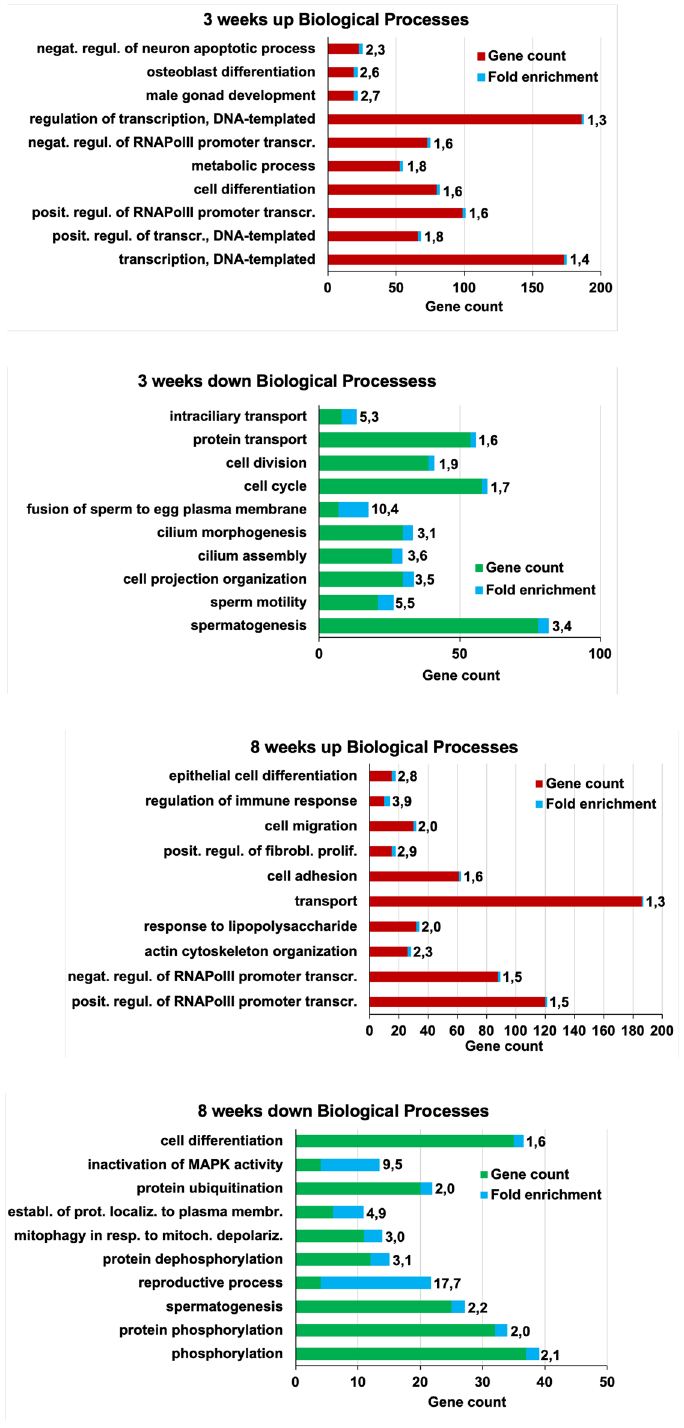
Figure 4. TOP 10 and TOP 11 Gene Ontology enrichment of biological processes of the up- and down- regulated DEGs of 3 and 8 weeks old murine testes. In red and green, up- and down-regulated genes, respectively. In blue and in numbers the fold enrichment. Note, the enrichment of spermatogenesis and male reproductive system associated processes in the down-regulated DEGs, while the up-regulated DEGs are enriched for a variety of somatic tissues and